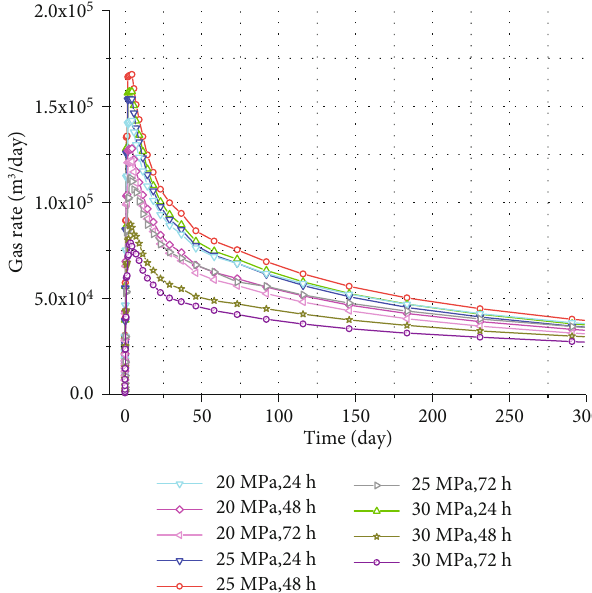
Figure 16: Evolution of the gas production ratio at di ff erent water injection pressures and water injection